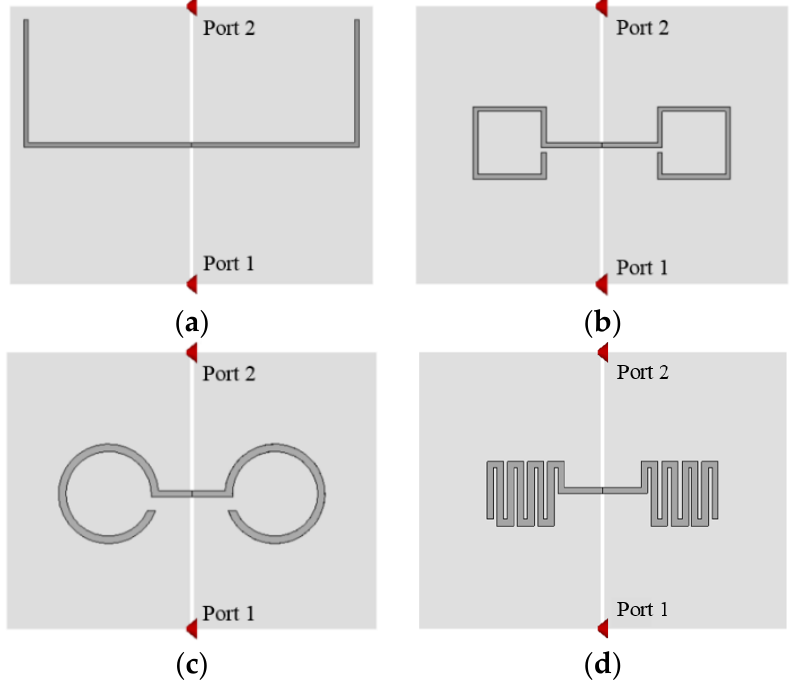
Figure 4. Resonance shapes ( a ) bent dipole, ( b ) square ring, ( c ) round ring, and ( d ) meander line. Table 1. Characteristics of narrowband resonators.